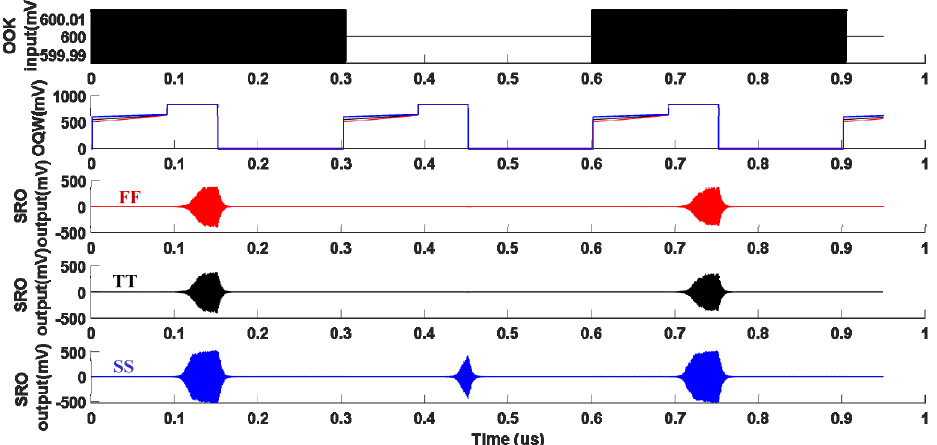
Figure 14. The simulation results illustrating the SRR’s immunity against process variations when the conventional optimal quenching waveform is applied. From top to bottom: input OOK signal, the combined CQW waveform, and the SRO output signals under process variation (the red line for the fastest-speed process corner (FF), the black is for the typical (TT), and the blue is for the slowest one (SS)).